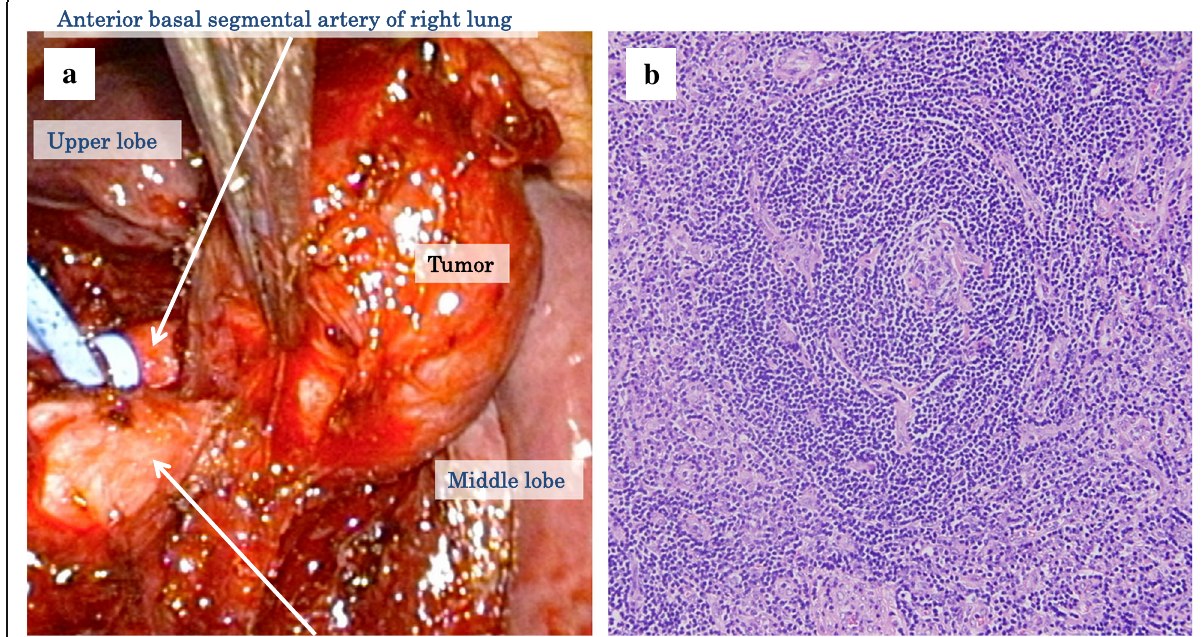
Fig. 2. Operative findings and histological findings. a The tumor existed between middle and lower lobe of the right lung. Because no tumor invasion into the pulmonary artery and/or lung parenchyma were found, only the tumor enucleation was carried out. b There were clearly hyalinizing concentric fibrotic nests around the lymph follicle and vessel hyperplasia on the hyalinizing wall. There were almost no plasma cells outside the follicle. Histological diagnosis was HV type